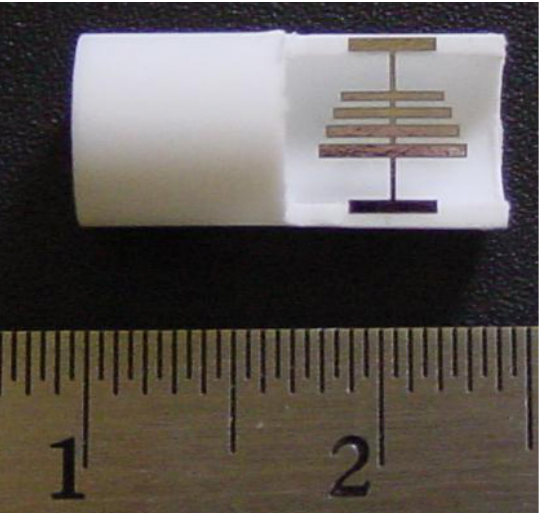
Figure 15. A magnetoelastic sensor array consisting of four sensor elements (the four horizontal strips at the center) mounted on a tube at its support tabs (the top and bottom strips). The major scale is in cm.